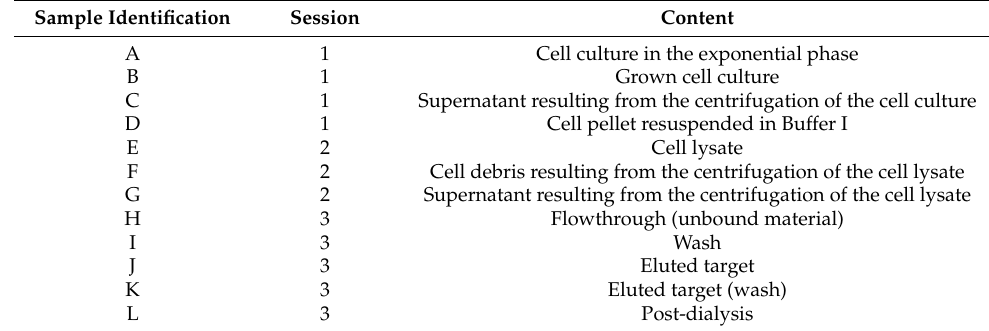
Table 3. List of samples to be analyzed in Session 4, 5 and